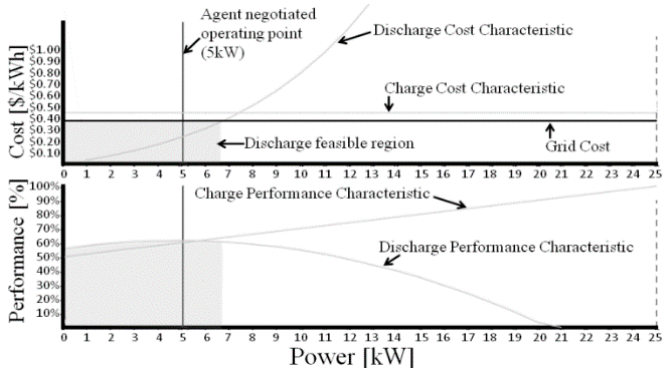
Figure 15. The pre-disturbance cost and performance characteristics for the storage producer and consumer agents. The solid vertical line represents actual battery dispatch; the dotted vertical line represents the dispatch limit.